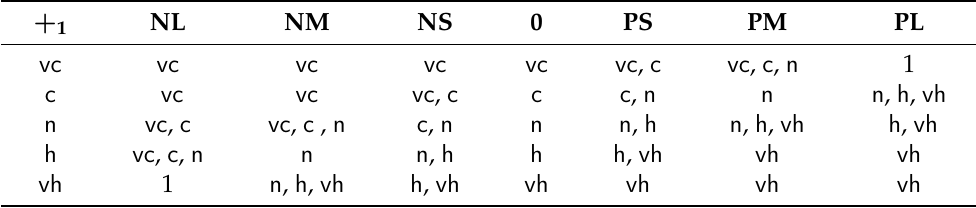
Table 2. Composition of components of L 1 ( L 2